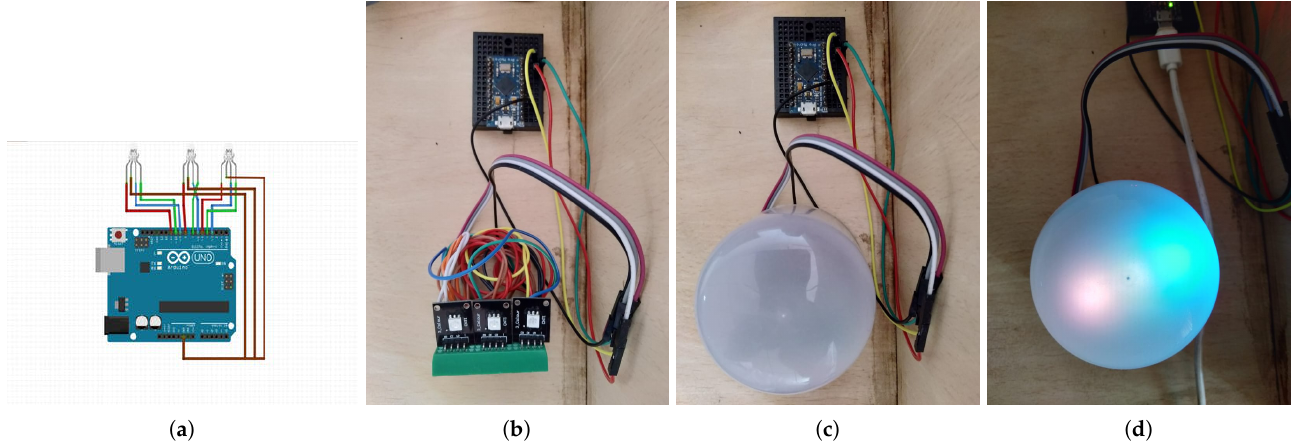
Figure 7. Li-Fi Transmitter. ( a ) Transmitter Circuit. ( b ) VLC Transmitter. ( c ) VLC Transmitter with Diffuser. ( d ) Operational VLC Transmitter.